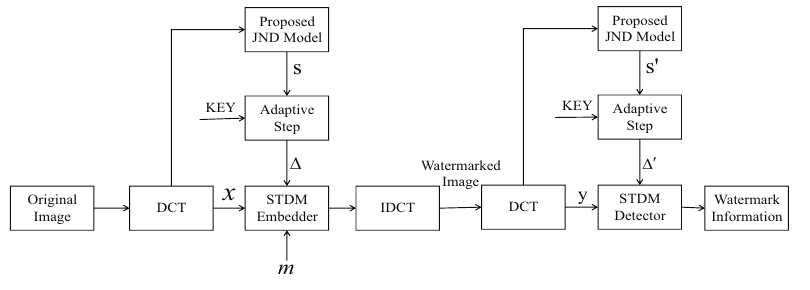
Figure 2. The proposed watermarking